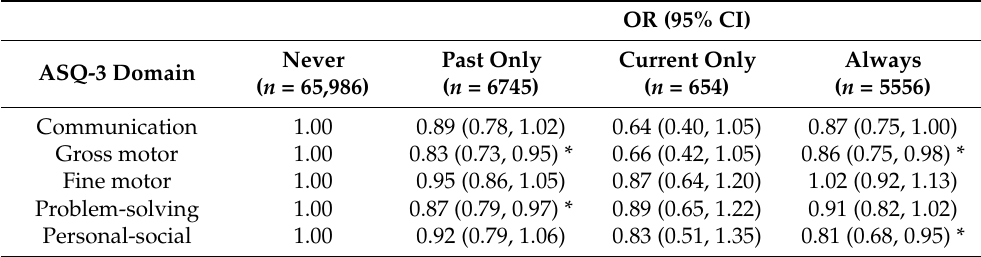
Table 4. Child development delays at 3 years of age in association with family dog